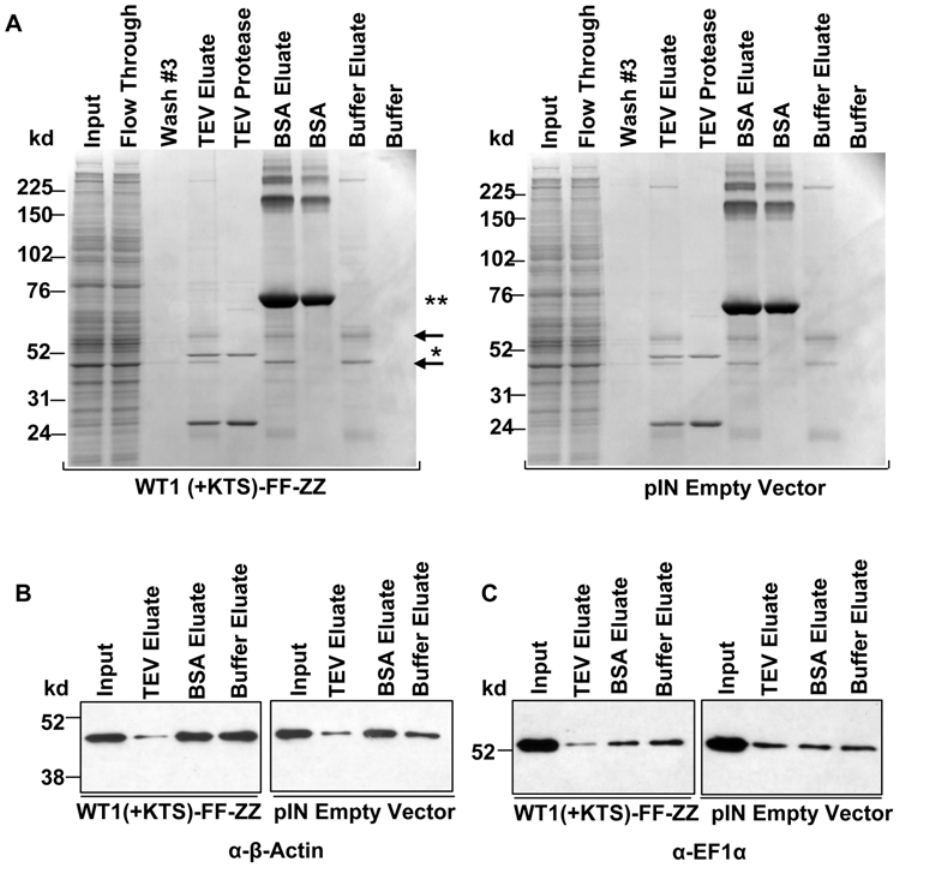
Figure 4. Protein components of the actin cytoskeleton are present in eluates used to identify the enriched subset of mRNAs. (A) Coomassie stained gels demonstrating proteins present in the IP eluates using MPC-5 cell extracts stably expressing WT1( + KTS)-FF-ZZ or empty vector expression constructs. Arrows correspond to the bands from TEV eluate lane of the WT1( + KTS)-FF-ZZ gel that were excised and submitted for mass spectrometry analysis. The same arrows also indicate the bands which correspond to tubulin and elongation factor 1 a (top arrow) and actin (bottom arrow). * indicates TEV protease and ** indicates BSA bands. The actin (B) and elongation factor 1 a (C) proteins are not enriched in the eluates from IgG beads. Immunoblots confirming the presence, but lack of enrichment of b -actin and elongation factor 1 a in eluate samples from WT1( + KTS)-FF-ZZ and empty vector control pulldowns with anti- b -actin and anti-elongation factor 1 a antibodies.